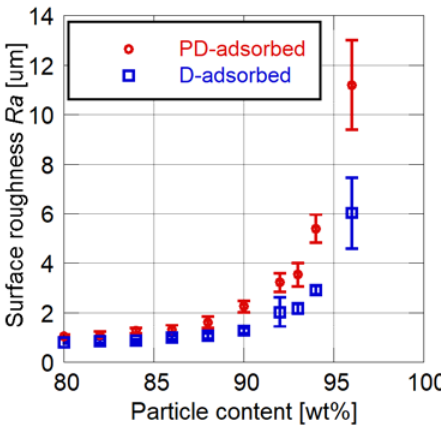
Figure 5. Surface roughness related to particle content.